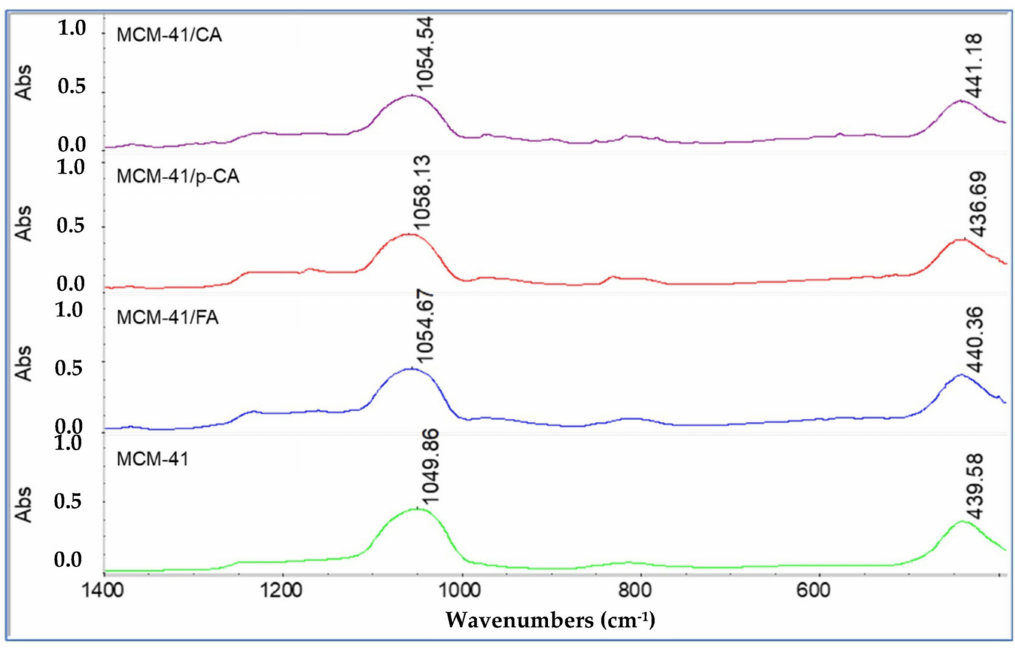
Figure 7. FTIR spectra of samples MCM-41, MCM-41/CA, MCM-41/p-CA and MCM-41/FA (visual- ization on the 400–1400 cm − 1